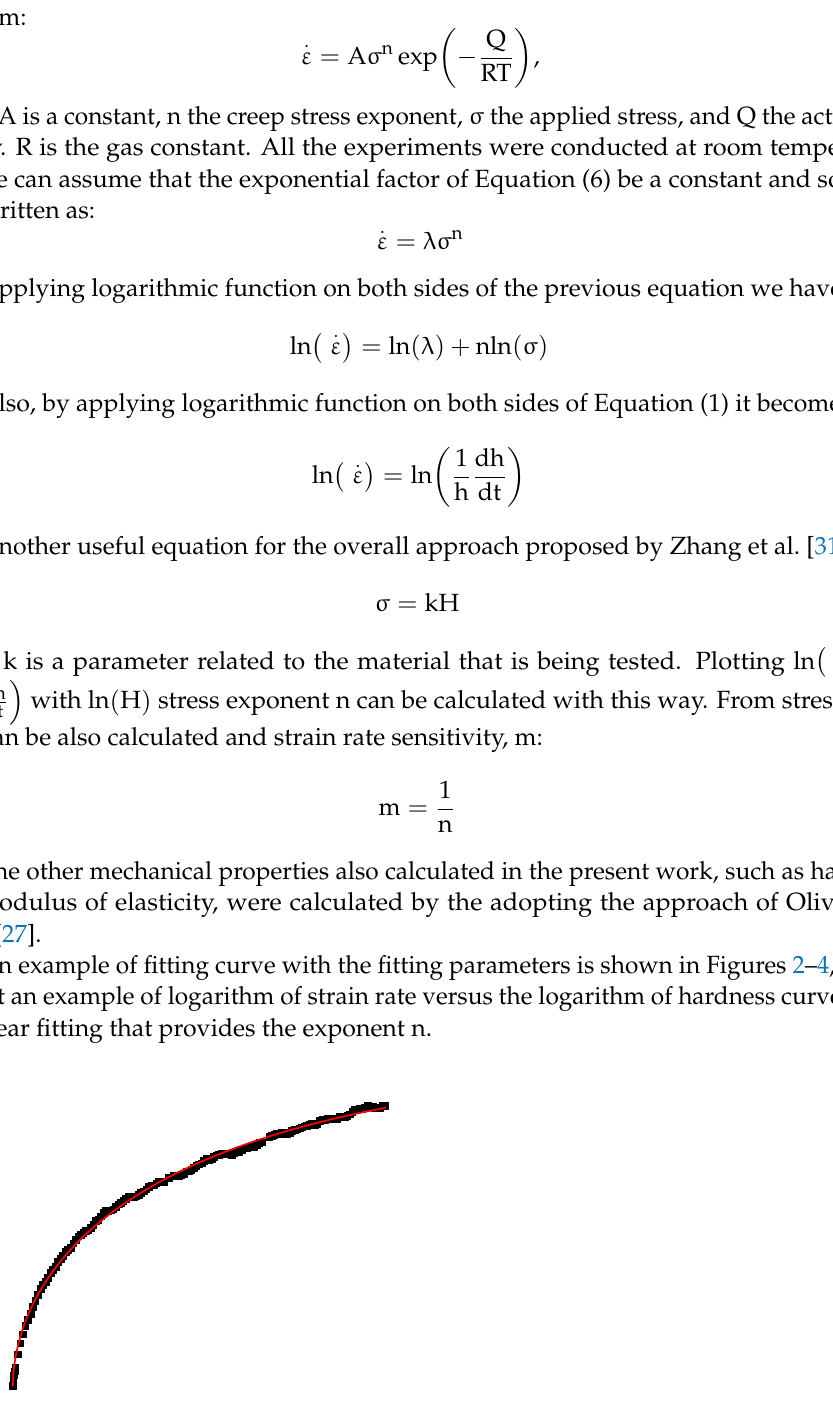
Figure 3. Linear fitting on steady creep area for extrapolated stress exponent (n) slope calculation.